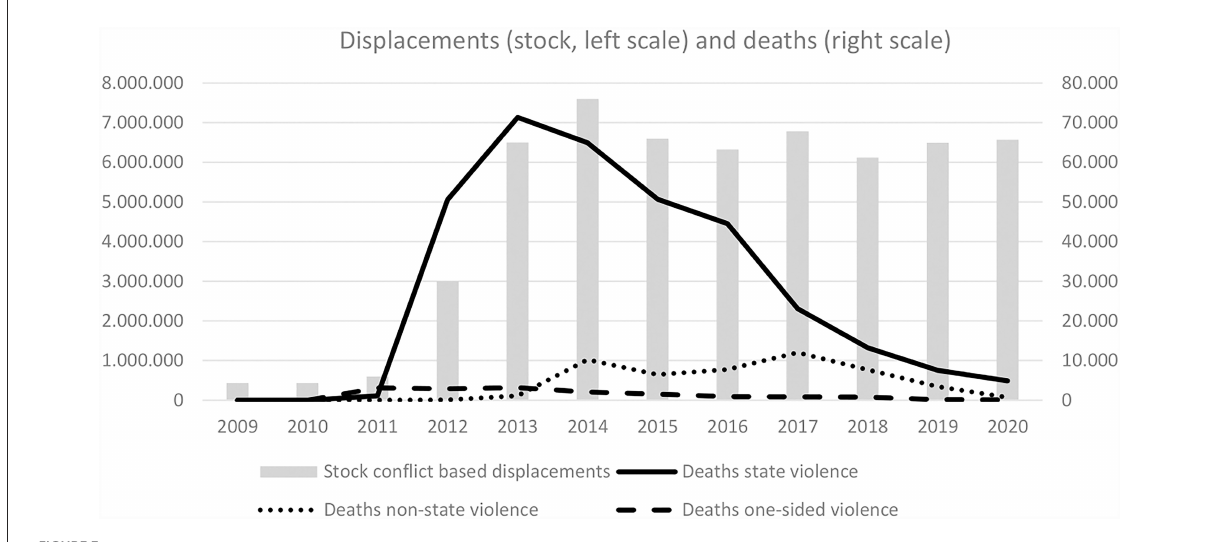
FIGURE3 Conflict-based displacements and deaths in Syria 2009–2020. Source: Own elaboration based on https://ucdp.uu.se/country/652 and https://